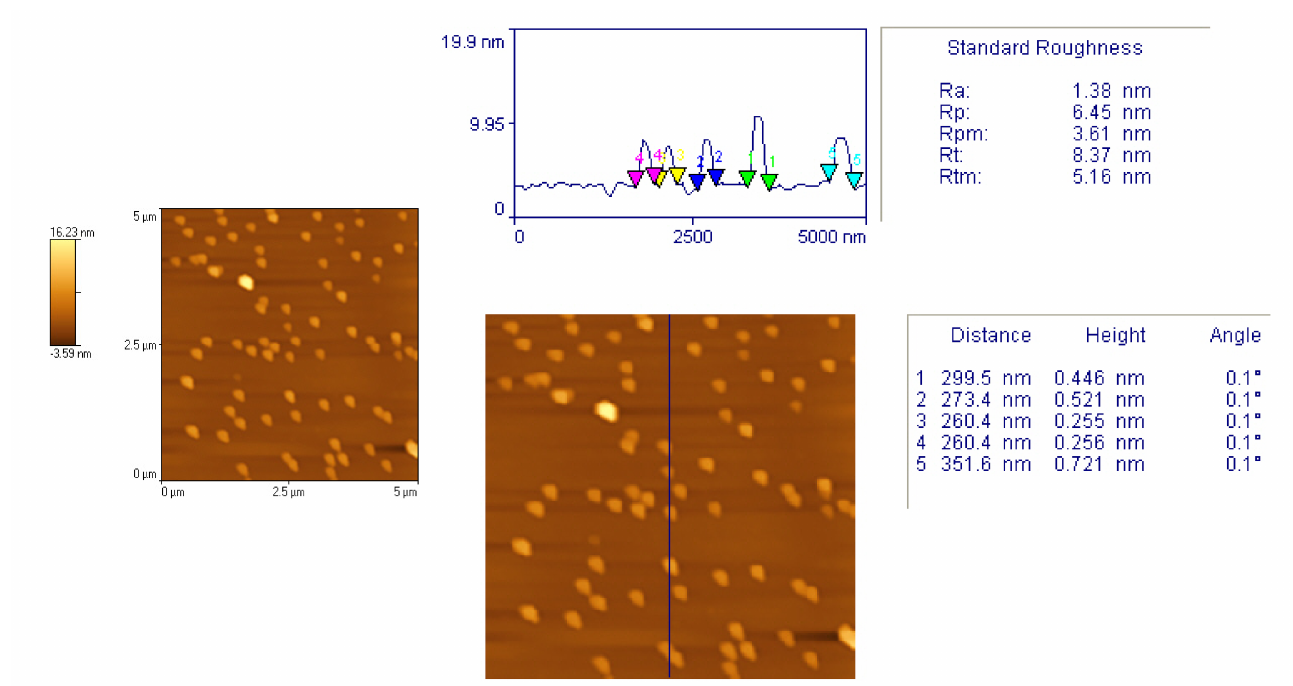
Figure 3. Atomic force